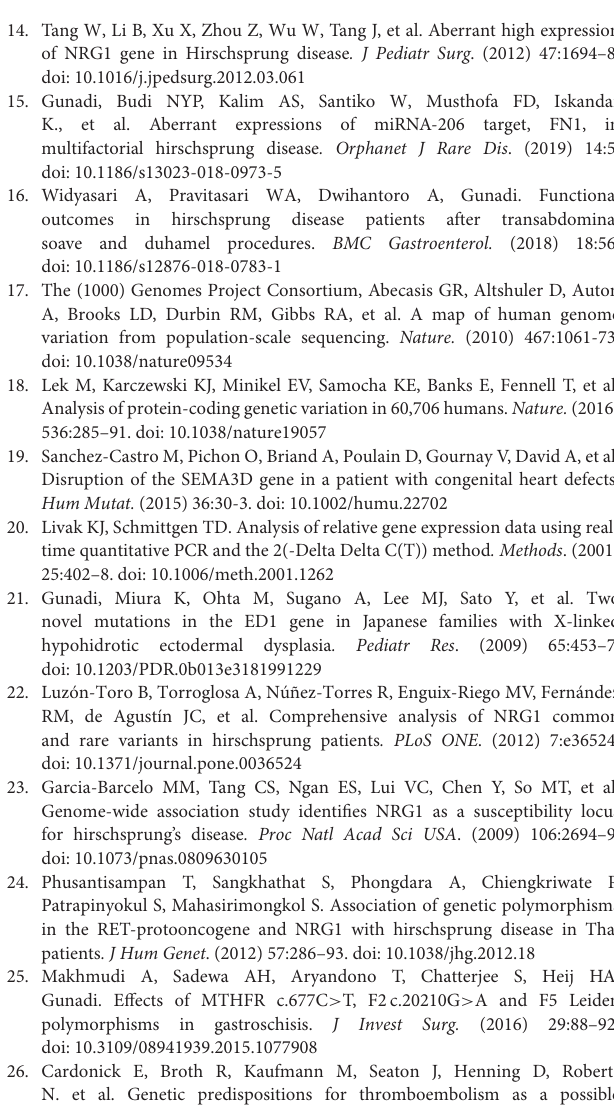
Supplemental Figure S1 | Gel electrophoresis of qPCR: (A) GAPDH and (B) SEMA3D expressions for HSCR ganglionic, aganglionic, and control colons. M: 100 bp DNA ladder; G: ganglionic colon; A: aganglionic colon; C: control colon; W: no